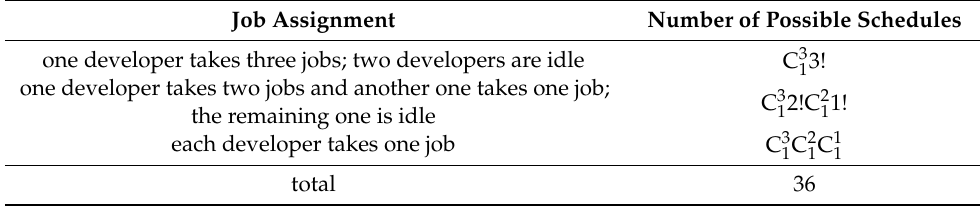
Table 2. The number of all possible schedules. Job Assignment Number of Possible